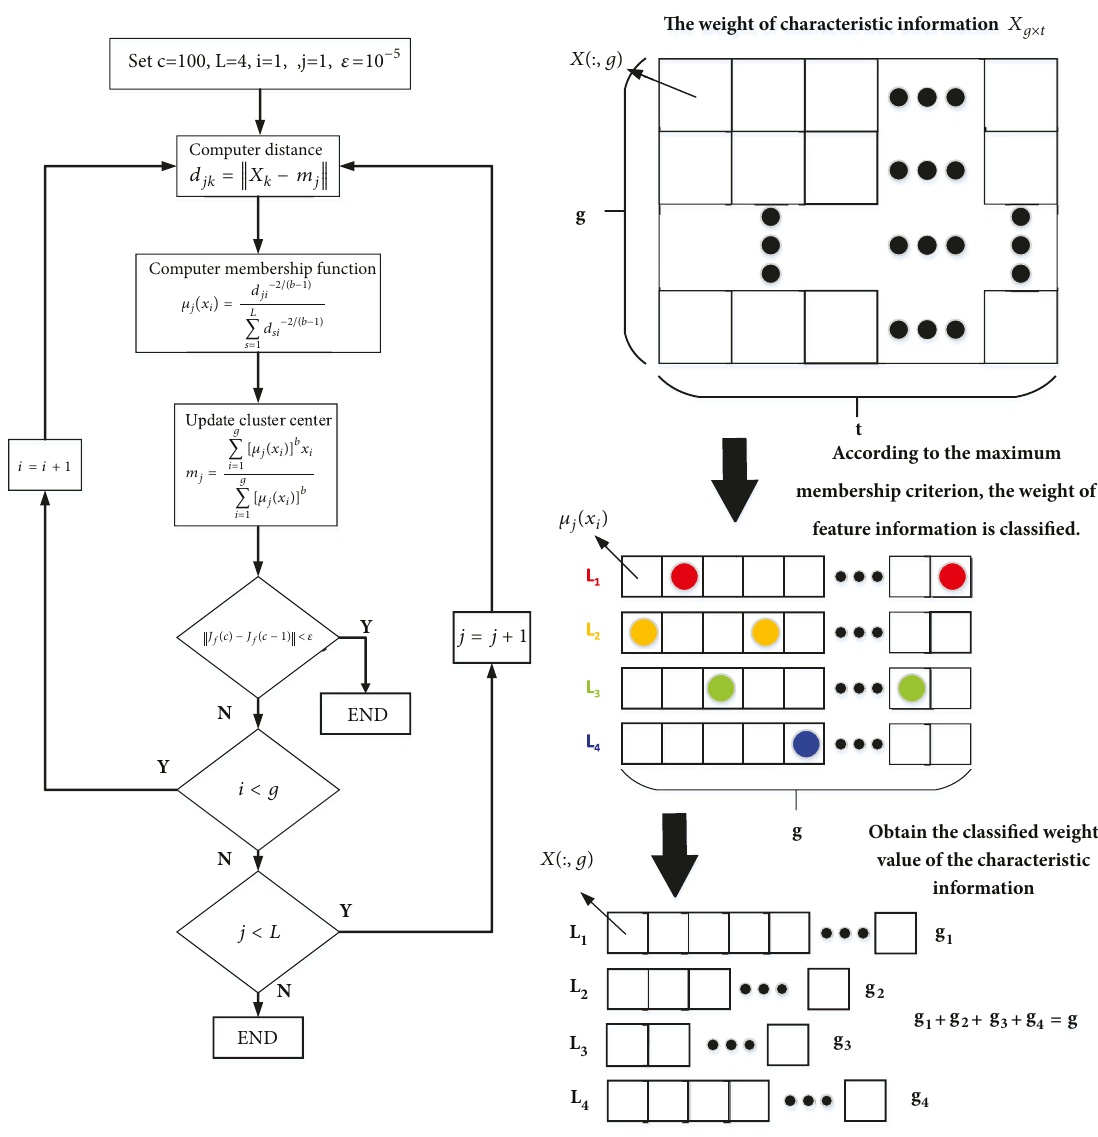
Figure 4: The specific process of Step